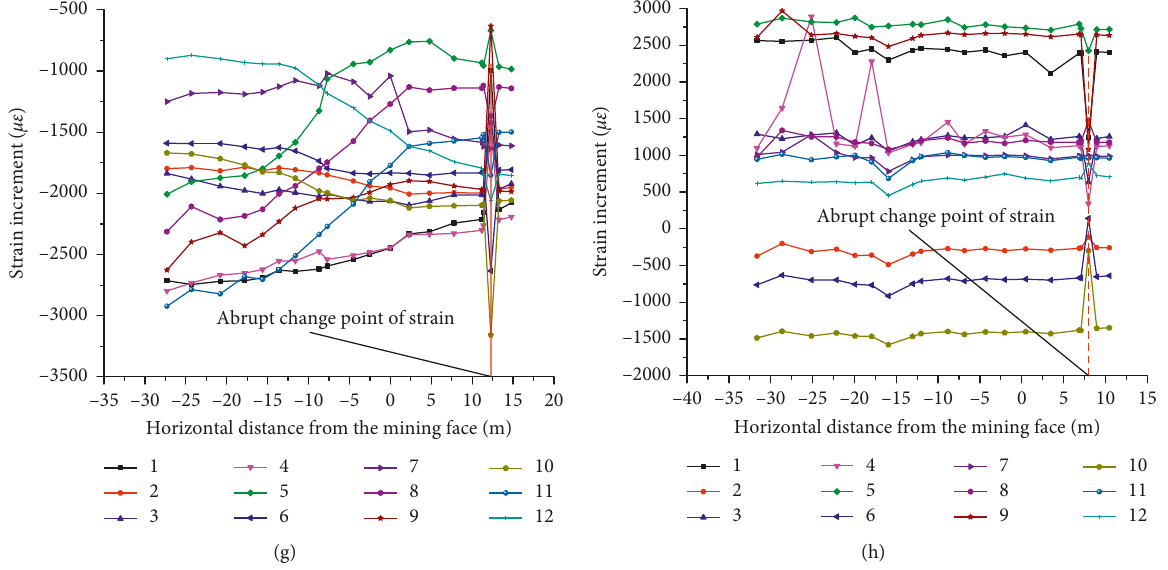
Figure 6: Strain increment curves of each sensor in boreholes III and IV in the 100502-180 mining face. (a) Sensor #10. (b) Sensor #11. (c) Sensor #12. (d) Sensor #13. (e) Sensor #14. (f) Sensor #15. (g) Sensor #16. (h) Sensor